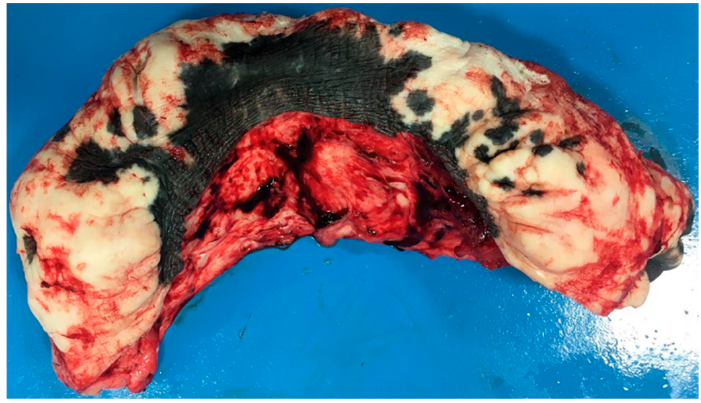
Figure 15. Appearance of the preputial mass after resection (clinical case